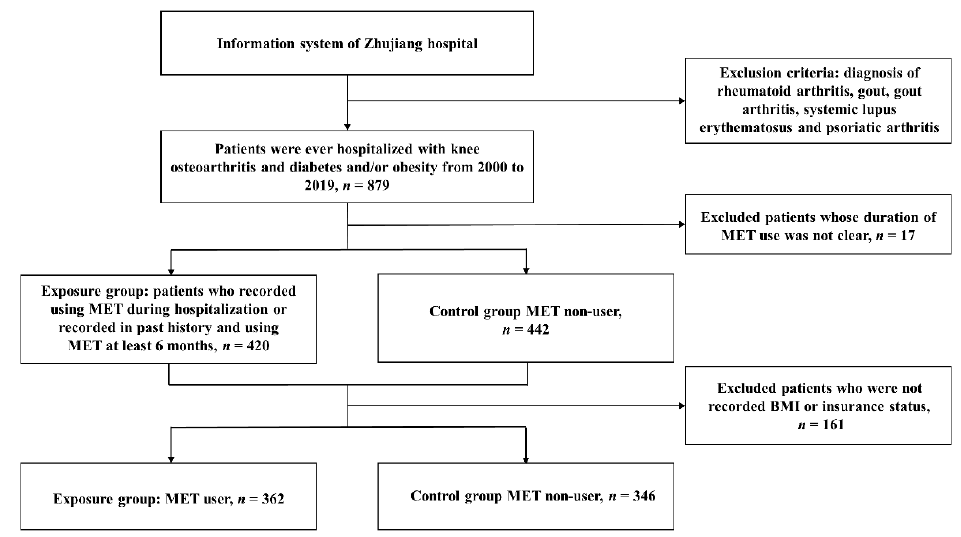
Figure 1. The flowchart of study population selection. Missing data had been excluded before performing IPTW.